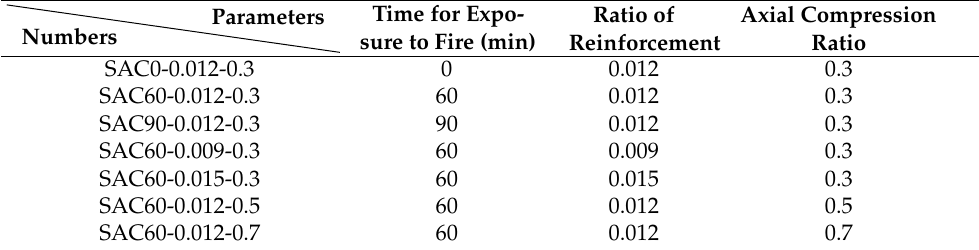
Table 8. Numbers and parameters of joint